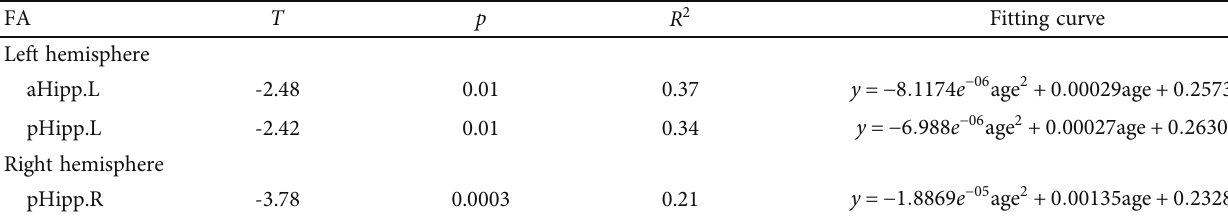
Table 4: Results of multiple regression analyses between FA and